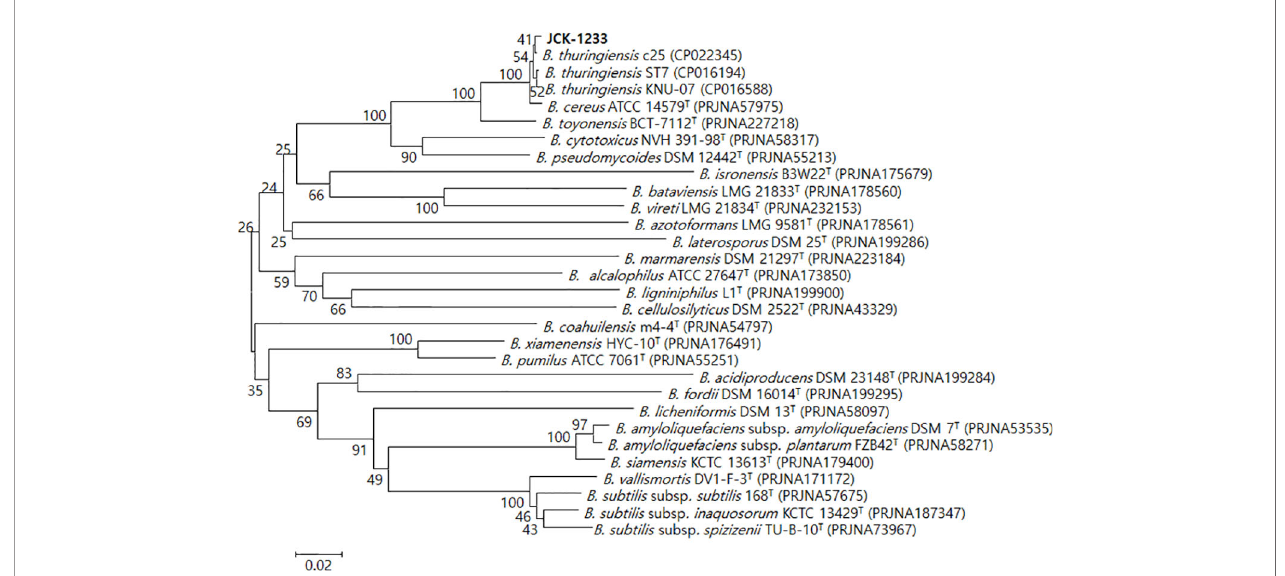
FIGURE 2 | Phylogenetic tree derived from a distance analysis of recA gene sequences in JCK-1233. The sequences were aligned using MEGA 6.0 software. The phylogenetic tree was constructed using the neighbor-joining (NJ) method with bootstrap analysis (1,000 trials). The selected strain was identi fi ed as Bacillus thuringiensis , which was separated in an exclusive cluster. Bars indicate the percentage of sequence divergence. T represents the type